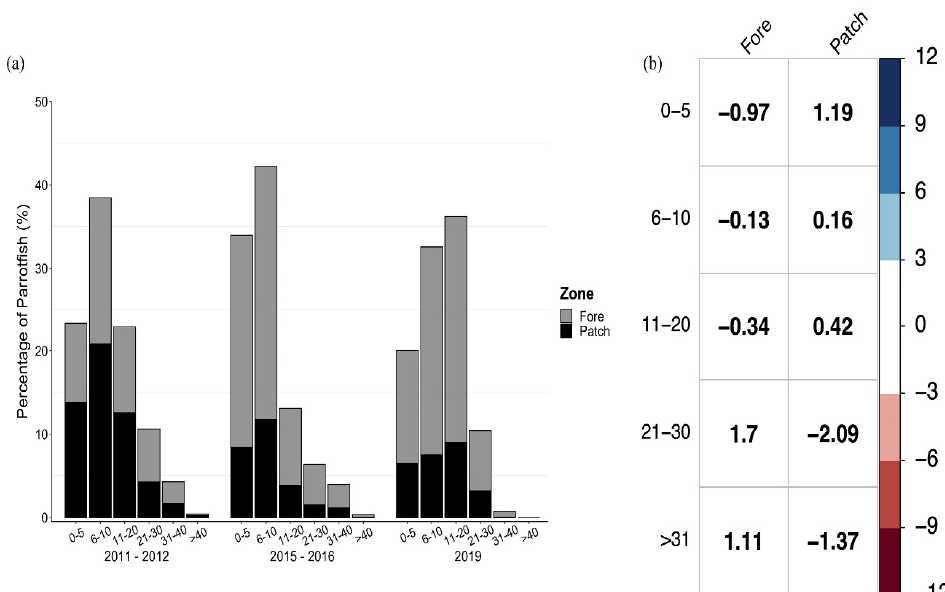
Figure 8. ( a ) Size frequency distribution showing the percentage of all parrotfish in different size classes across each survey period by reef zone and ( b ) corrplot illustrating the Pearson residuals for each size class contributing to the global chi-square statistic. The residual cutoff used to indicate a significant deviance from the expected standardized residuals of the global chi-square test is set at ±2.807. Color indicates the sign and magnitude of the residuals as follows: blue is significantly positive, red is significantly negative and white is non-significant.